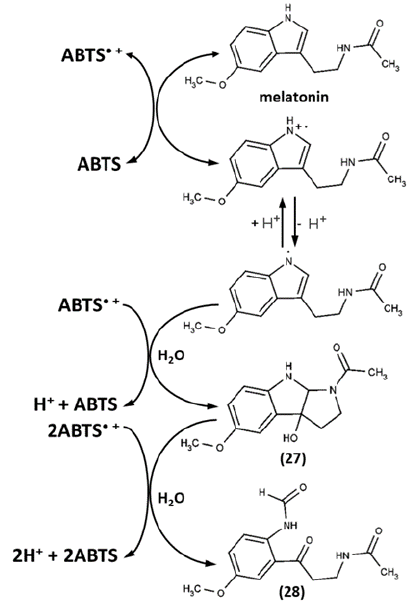
Figure 12. Reaction pathways of melatonin oxidation by ABTS • + [136]. Copyright 2003, adopted with permission from John Wiley & Sons Ltd.